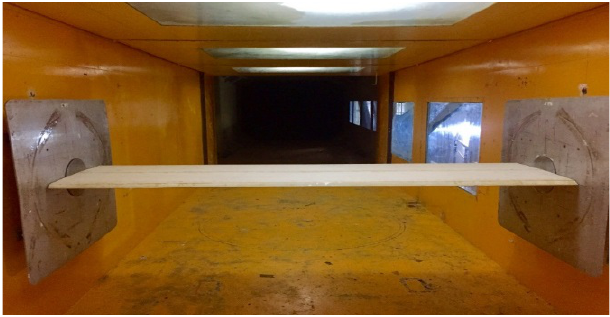
Figure 8. Three-component force test of sectional model.